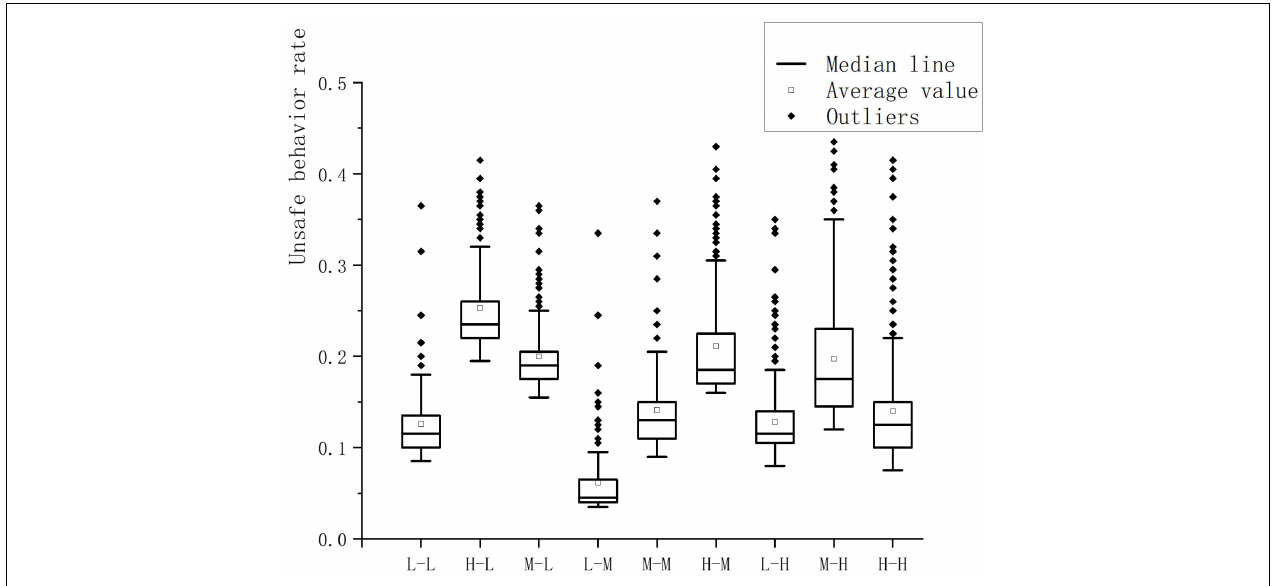
FIGURE 5 | The evolution of unsafe behaviors of workers in the context of different levels of conformity mentality and formal rule